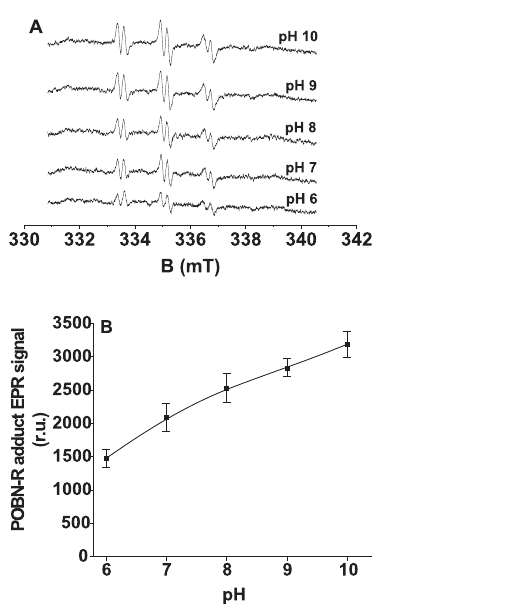
Figure 5. Effect of propyl gallate on TEMPONE and EMPO-R adduct EPR spectra measured in Tris-treated PSII membranes. [A] Tris-treated PSII membranes (200 m g Chl ml 2 1 ) were illuminated with white light (1000 m mol m 2 2 s 2 1 ) for 30 min in the absence (Light) and the presence (Light + PG) of 5 mM propyl gallate. Other experimen- tal conditions were the same as described in Figure 1. [B] Tris-treated PSII membranes (200 m g Chl ml 2 1 ) were illuminated with white light (1000 m mol m 2 2 s 2 1 ) for 30 min in 40 mM MES-NaOH (pH 6.5), then added spin trap EMPO and measured the spectra without further illumination (dark). Due to the instability of EMPO-R adduct for a longer period illumination, Tris-treated PSII membranes were first illuminated 30 min in the absence of spin trap and then illuminated for additional 2 min in the presence of spin trap EMPO (Light). Tris-treated PSII membranes were first illuminated 30 min in the in the presence of 5 mM propyl gallate and then illuminated for additional 2 min by adding spin trap EMPO (Light +